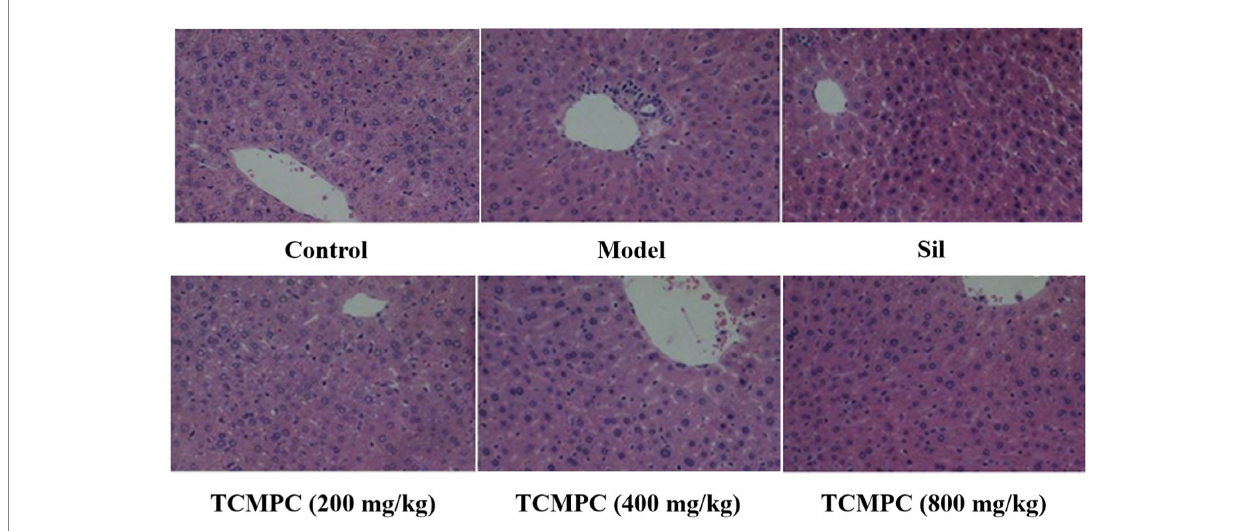
FIGURE 5 Liver pathology by H&E staining. Representative H&E-stained liver tissue sections are shown at 200x